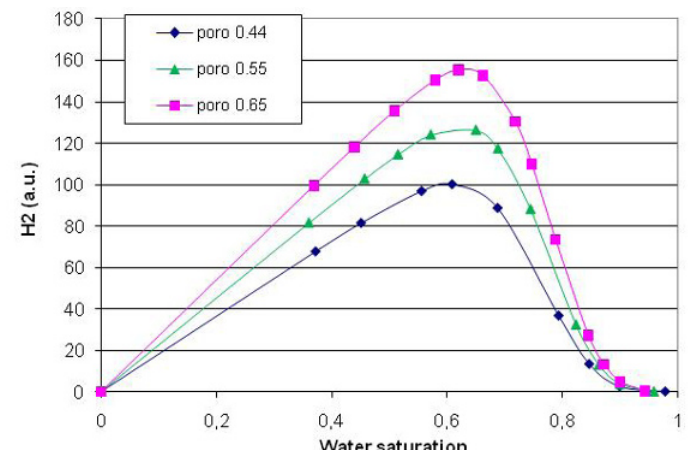
Fig. 6: Dihydrogen production for 100 years as a function of hydraulic binder porosity.